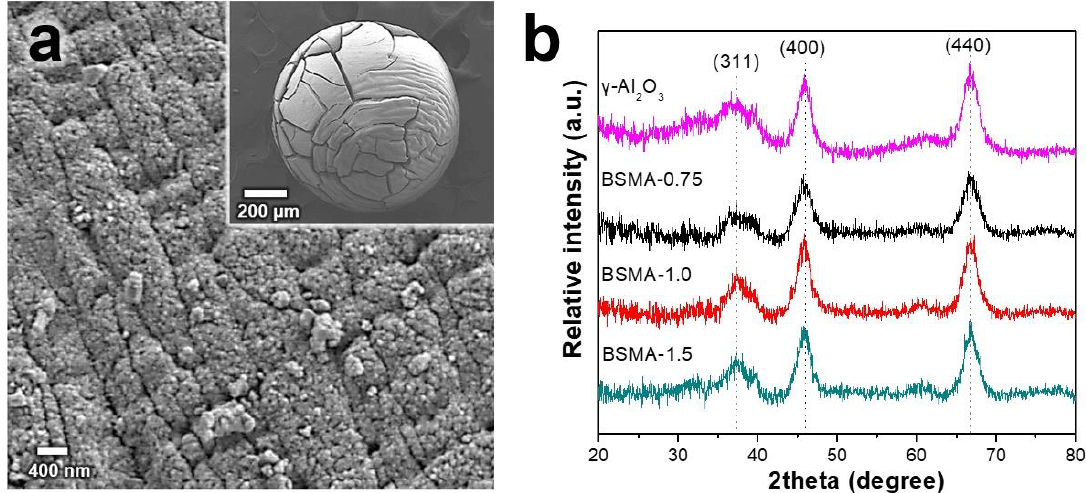
γ -Al 2 O 3 and BSMA